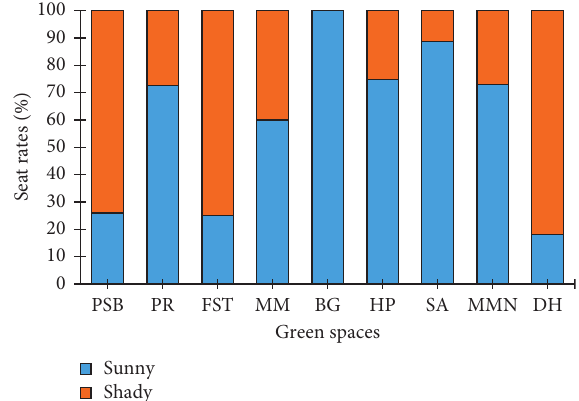
Figure 5: Seating and sunshine in the various green spaces. Pre- fecture garden (HP), Saint-Anne garden (SA), Blanche Gomes garden (BG), Marien Ngouabi Museum garden (MMN), Ministry of Mines square (MM), Pierre Savorgnon De Brazza garden (PSB), Rotary Club square (PR), Faculty of Science and Technology square (FST), and Human rights square (DH).